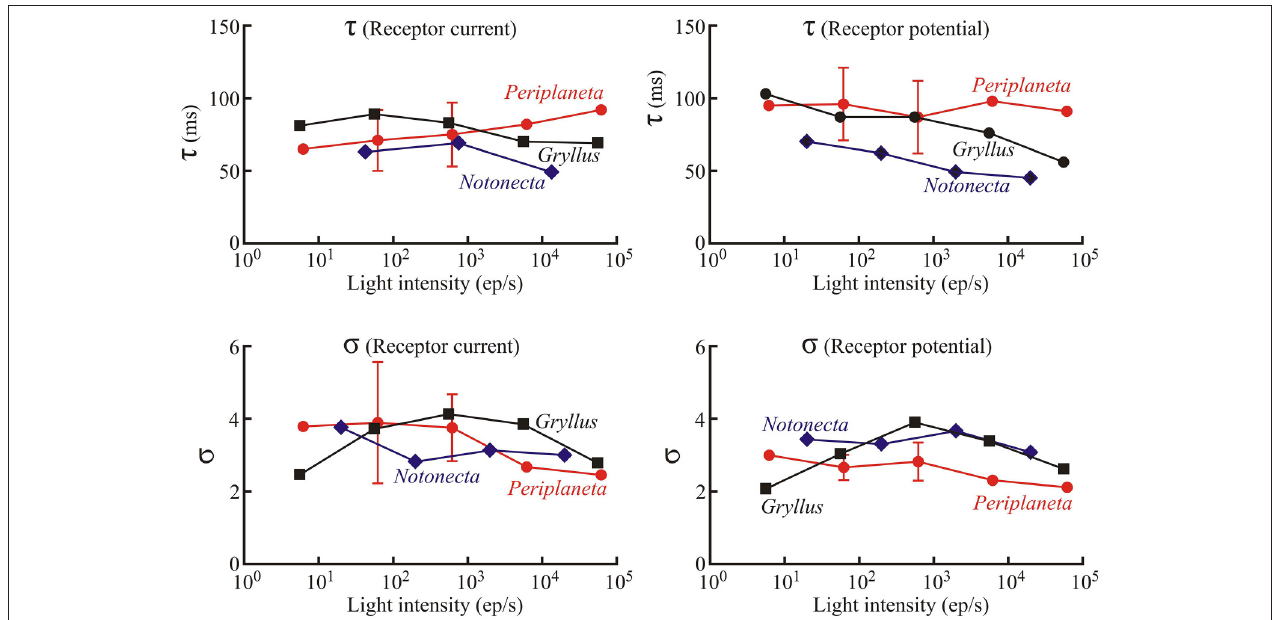
FIGURE 5 | Values of the Log-normal parameters, τ and σ , as functions of light intensity as in Figure 3. Numbers of experiments contributing to Periplaneta data were: 1, 6, 5, 2, and 1 for increasing light levels. Mean values of multiple experiments are shown, and standard deviations are shown for experiments with five and six estimates. All other values represent fitted values to single